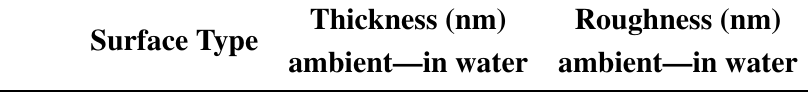
Table 1. Thickness and RMS roughness results of modified surfaces